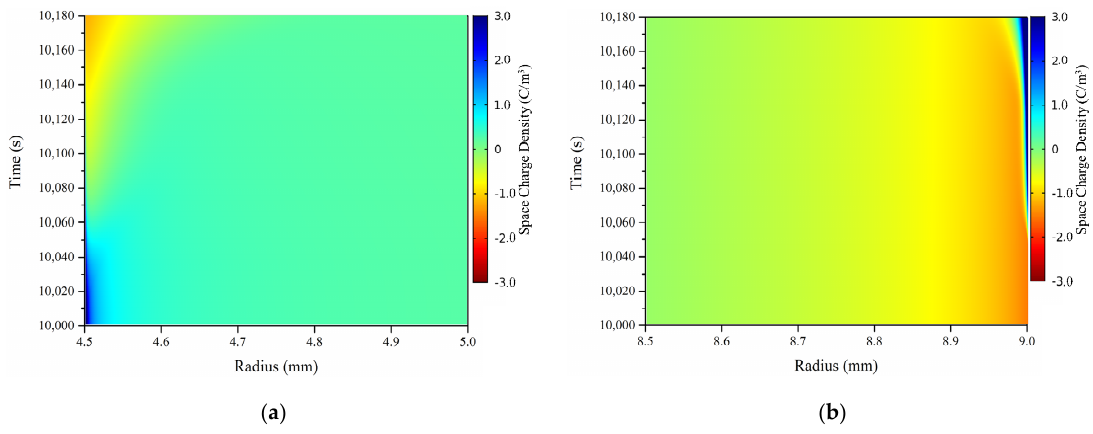
Figure 16. Space charge distribution at 350 A and potential zero duration 60 s: ( a ) Conductor side charge density (C/m 3 ); ( b ) sheath side charge density (C/m 3 ).